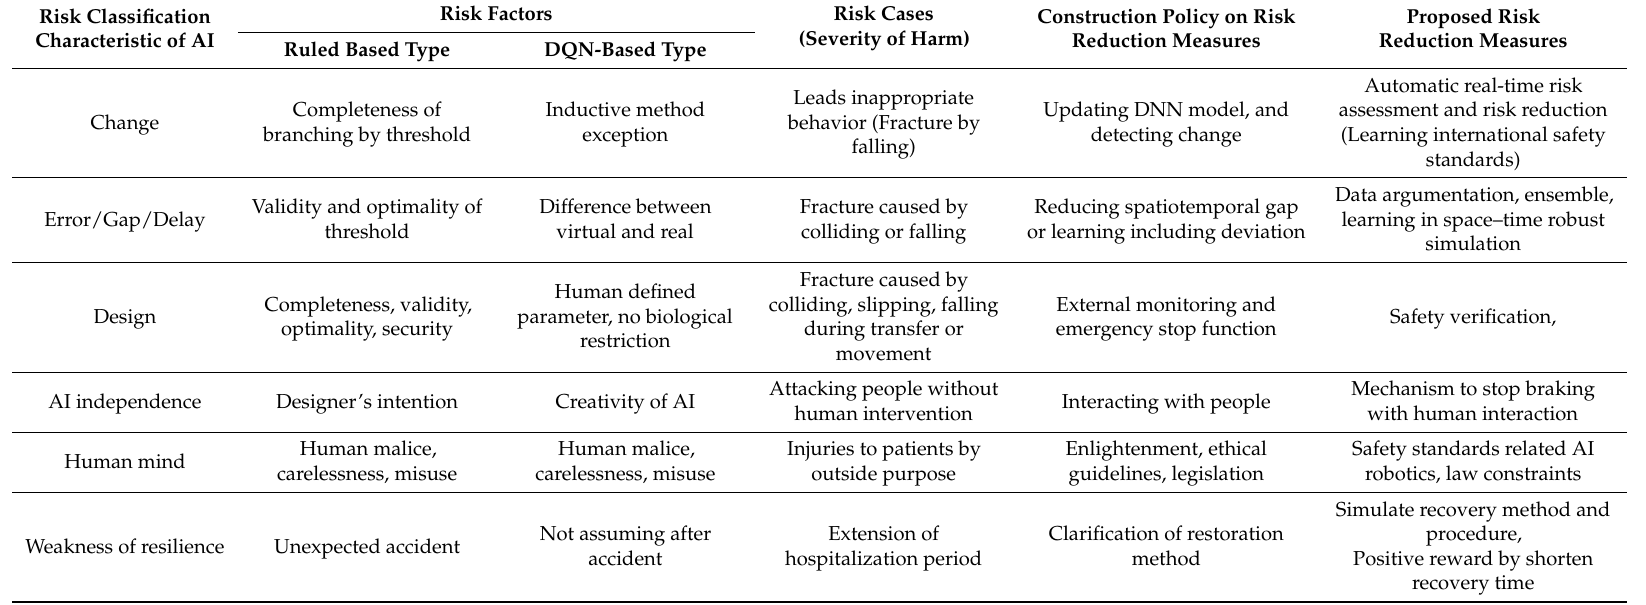
Table 3. Systemization of risks and proposal of risk reduction